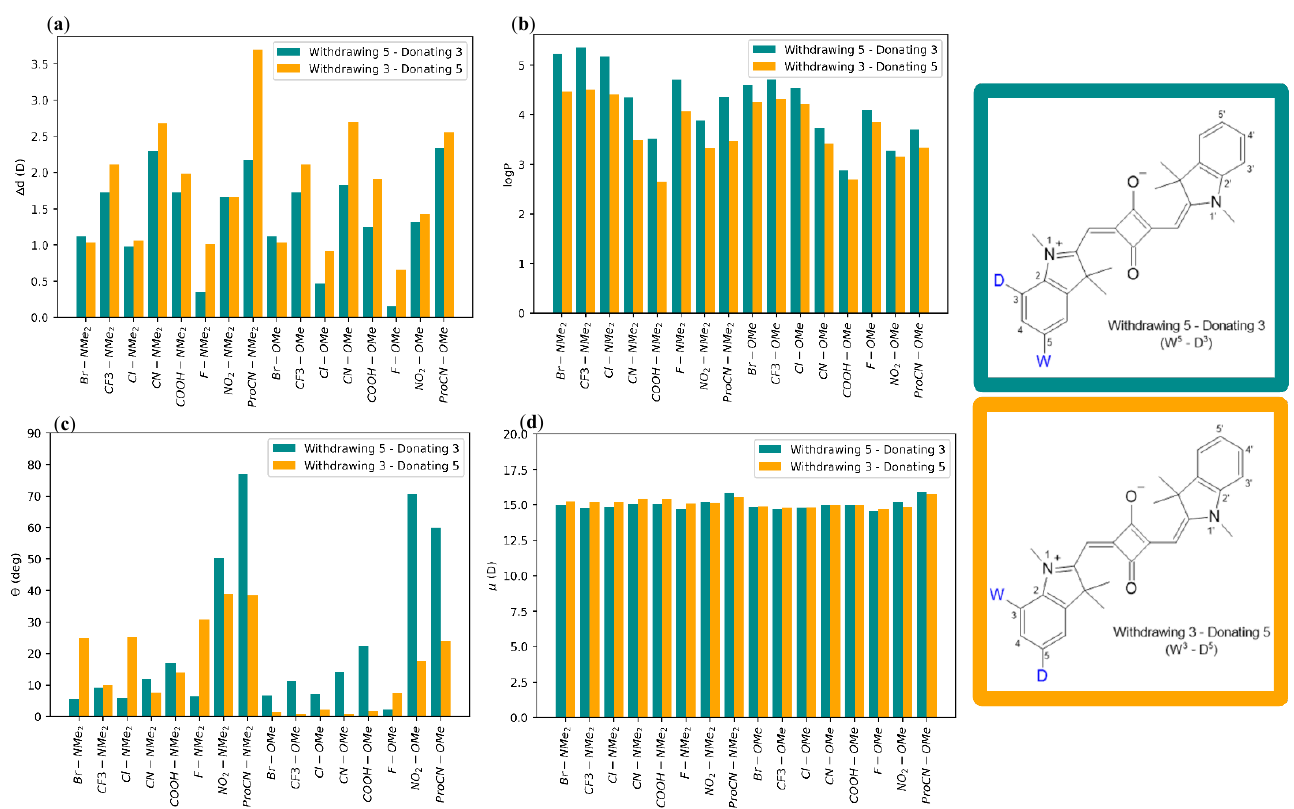
Figure 6. ( a ) Δd values of same- side substituent pairs, ( b ) logP of same- side substituent pairs, ( c ) θ values for all same - side substituent pairs, and ( d ) μ values of same- side substituent pairs. “Withdrawing 5– Donating 3” refers to a configuration where the first listed substituent is located on position 5, and the second listed substituent is located on position 3. “Withdrawing 3– Donating 5” refers to a configuration where the first listed substituent is on position 3 and the second listed substituent is placed on position 5. Δd, θ, and μ calculations were performed in implicit water.